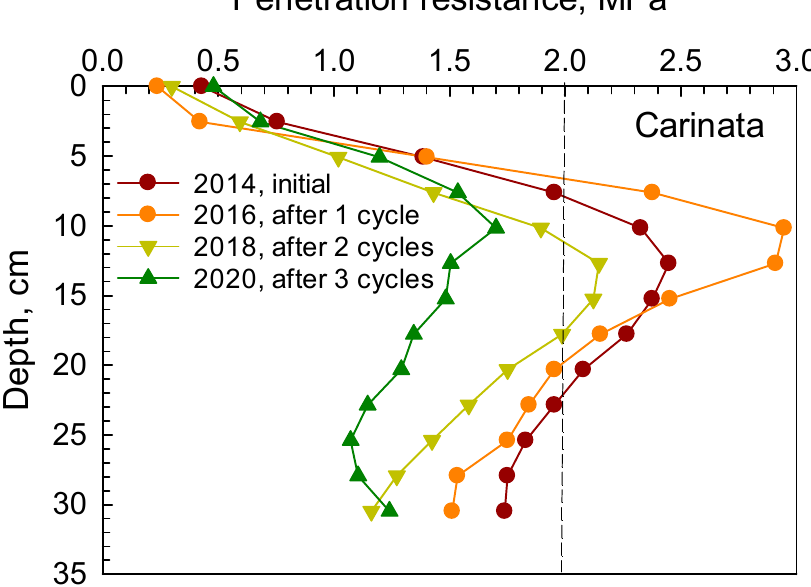
Figure 3. Initial mean soil penetration resistance across all plots in 2014 and after 1 cycle in 2016, after 2 cycles in 2018, and after 3 cycles in 2020 for carinata as a previous crop.